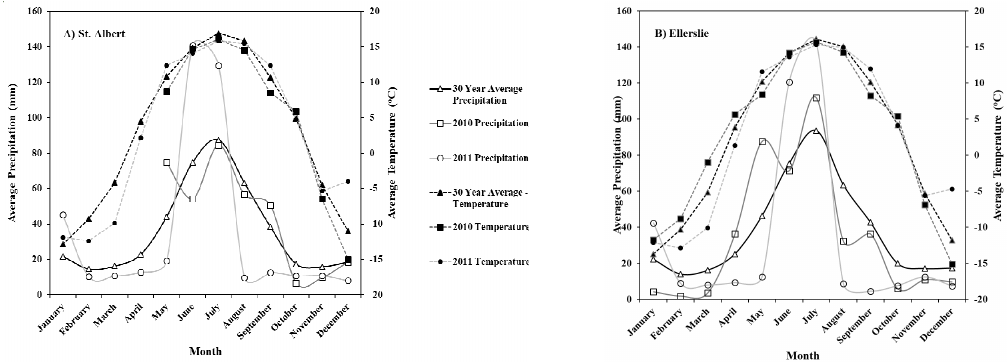
Figure 1. Monthly precipitation and temperature for 2010 and 2011 in relation to the long-term normal for each of the ( A ) St. Albert and ( B ) Ellerslie, study sites, during the study period.